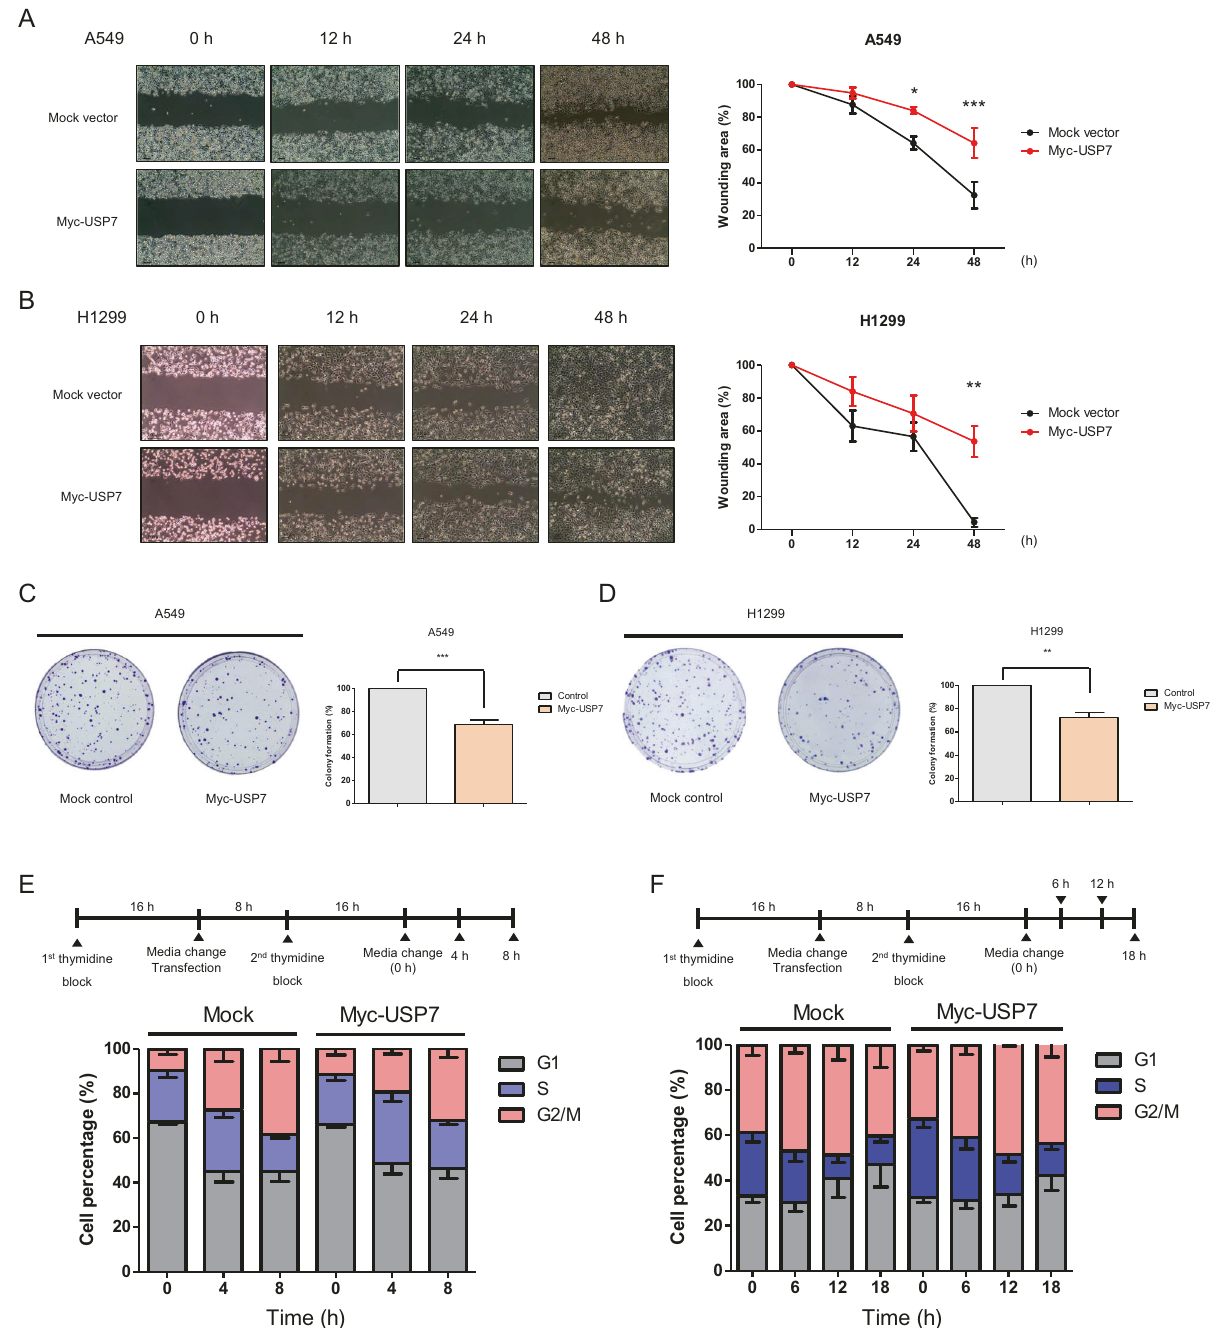
Fig. 5 USP7 inhibits LUAD cell proliferation via modulation of the ERK1/2 signaling pathway. A , B Wound healing assays were performed in Myc- USP7 -transfected A549 and H1299 cells and mock vector-transfected A549 and H1299 cells as controls. And cell images were captured at 0, 12, 24, and 48 h after scratch. Wound area (%) was determined by the rate of remaining wound area compared to control, * p < 0.05, *** p < 0.001, n = 4 (A549), n = 3 (H1299). C , D Colony-forming assays were performed in Myc- USP7 -transfected A549 and H1299 cells and mock vector-transfected A549 and H1299 cells as controls. Cells were stained with crystal violet solution and cell images were captured. The number of colonies is analyzed by image J and calculated by a two-tailed Student ’ s t -test, * p < 0.05, ** p < 0.01, n = 6 (A549), n = 4 (H1299). E Cell cycle a n alysis were performed in Myc- USP7 -transfected H1299 cells and mock vector-transfected H1299 cells as controls with fl ow cytometry. Cells were synchronized by double thymidine block and fi xed by 70% ethanol and stained by FxCycle ™ PI/RNase staining solution to analyze the cell cycle, and the percentage of cells in G1, S, and G2/M phases was measured in a time-dependent manner (0, 4, and 8 h). Representative data was shown from at least three independent experiments. F A549 cells were also synchronized by double thymidine block and fi xed by 70% ethanol and stained by FxCycle ™ PI/RNase staining solution to analyze the cell cycle, and the percentage of cells in G1, S, and G2/M phases was measured in a time-dependent manner (0, 6, 12, and 18 h). Representative data was shown from three independent experiments.